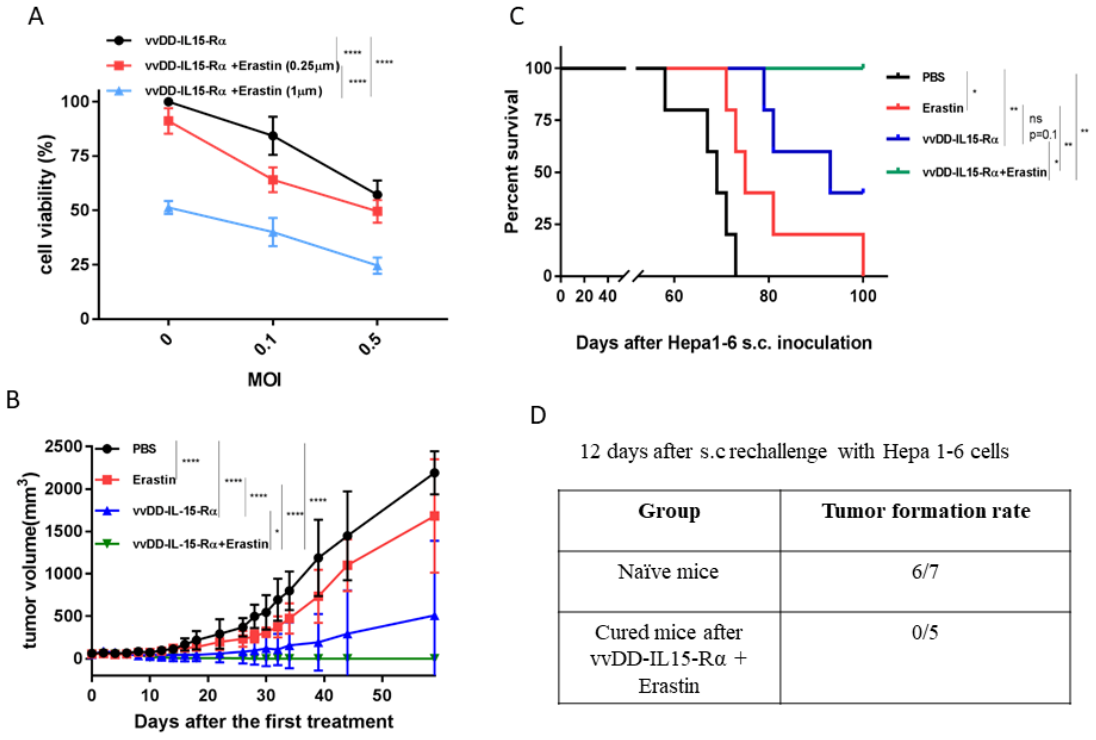
Figure 4. Combination therapy has superior anti-tumor response on Hepa1-6 tumor model. ( A ) Hepa1-6 cancer cells were plated at 1.0 × 10 4 /well in a 96-well plate and infected with vvDD- IL15-R α (MOI = 0, 0.1, 0.5) and/or erastin (0.25, 1.0 µ m) the next day. Cell viability was determined at 24 h after treatment using MTS assay. ( B – D ) B6 mice were inoculated subcutaneously (s.c.) with 2.0 × 10 6 Hepa1-6 tumor cells in 60 µ L volume and randomly divided into required groups ( n = 5 in each group). When tumor nodules reached ~5 × 5mm, vvDD-IL15-R α were intratumorally (i.t.) injected with 2.0 × 10 7 pfu/50 µ L for only one injection; erastin was intraperitoneally (i.p.) injected daily with 20 mg/kg for seven total injections. ( B ) The graphs represent a comparison of tumor growth in different treatment groups. ( C ) The survival of tumor-bearing mice was monitored using Kaplan–Meier analysis and statistical analyses were performed using a log rank test. ( D ) Tumor formation rate on day 12 post rechallenge s.c. with 2.0 × 10 6 Hepa1-6 cells. Two-way ANOVA was used to analyze the data (*, p < 0.05; **, p < 0.01; ****, p < 0.0001; and ns: not significant). This experiment was performed